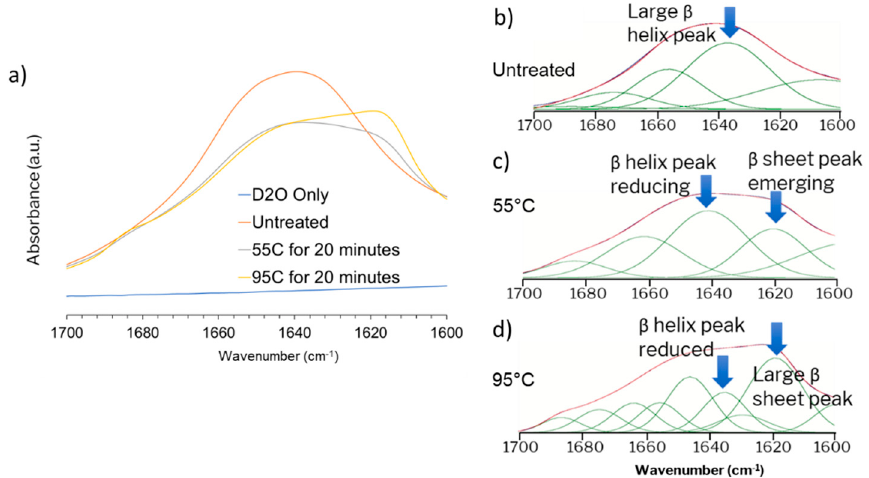
Figure 9. ( a ) FTIR spectra of D 2 O, untreated, 55 °C and 95 °C treated Snomax ® samples in the Amide-I region; ( b – d ) Peak resolve analysis of the amide-I region for distinguishing secondary structure of the ice nucleating protein inaZ in Snomax ® with the heat treatment conditions for the samples indicated in the image.